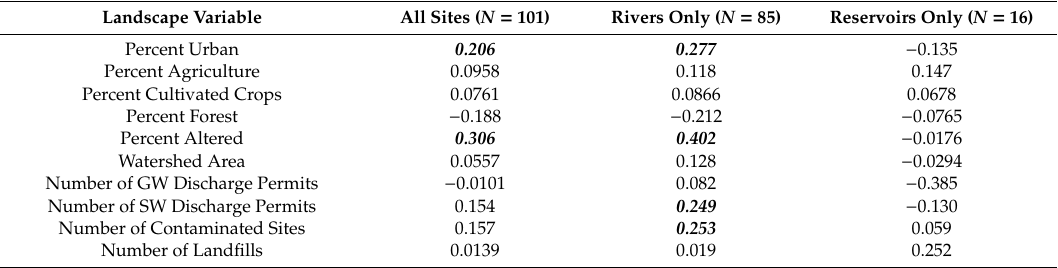
Table 2. Spearman rank-order correlations among surface water estrogenicity (ng / L) and select landscape variables. Values in bold / italics are statistically significant ( p ≤ 0.05).